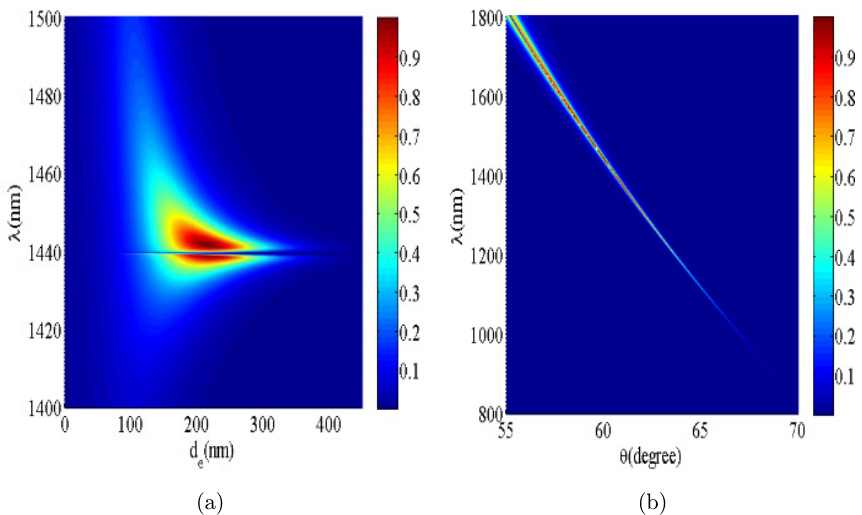
Fig. 5. The absorption map of the structure EG(BC) 2 for (a) A ( d e , (cid:6) ) and (b) A ( (cid:3) , (cid:6) ). The color bar indicates the absorption